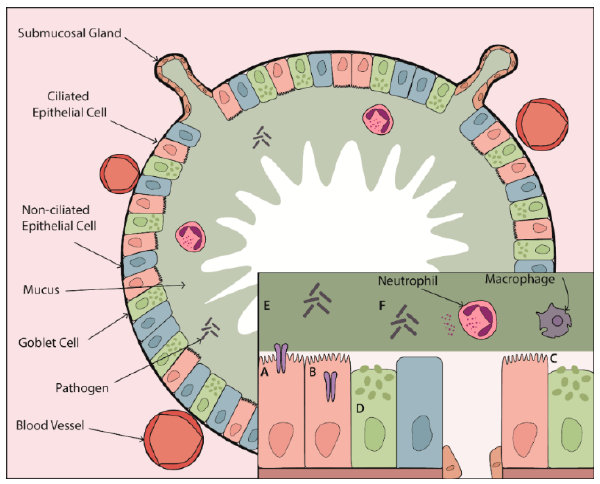
Figure 1. The effect of proteases on mucus and mucociliary clearance in the chronically inflamed airway. Proteases contribute to CLD pathogenesis through their impact on every step of the MCC mechanism. Elevated protease activity leads to ( A ) activation of ENaC and ( B ) loss of CFTR at the epithelial surface contributing to airway surface dehydration. ( C ) Protease-dependent damage to ciliated epithelial cells and cleavage of ciliary proteins leads to ineffective mucus clearance. This clearance defect is compounded by ( D ) protease-mediated increases in mucin expression and secretion from goblet cells and submucosal glands resulting in a highly viscous mucus layer that can no longer be cleared effectively. ( E ) Proteases can degrade mucins and ( F ) induce release of NETs, which may further alter mucus viscoelastic properties. Together, protease-dependent mucin/mucus hypersecretion and mucus dehydration produce highly viscous mucus, setting the stage for mucus plugging in the airways of patients with muco-obstructive lung disease.